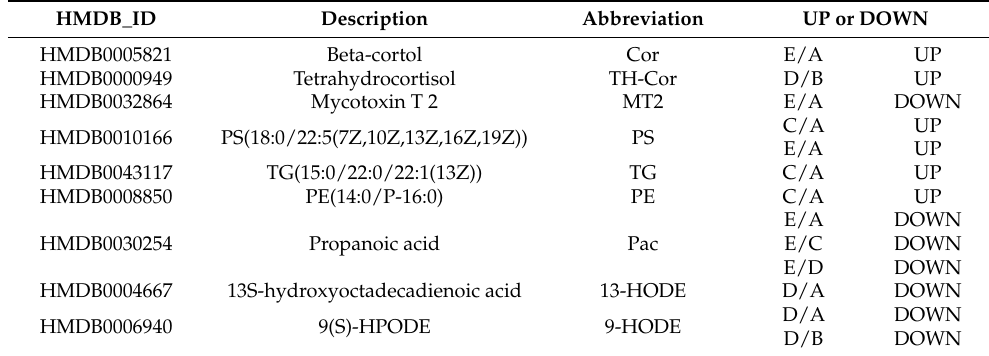
Table 1. The key differential